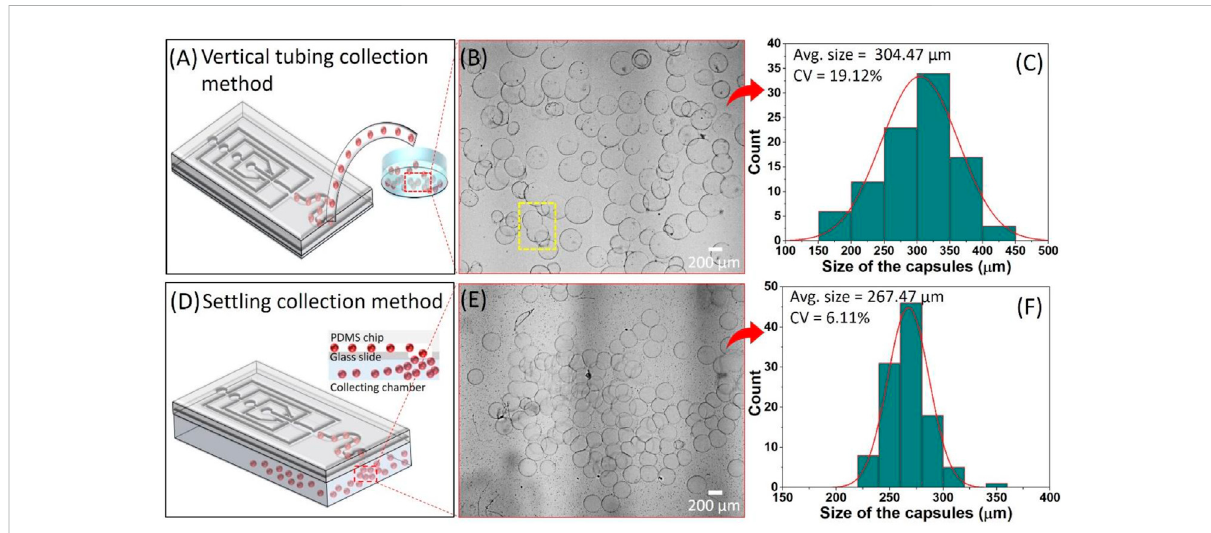
The collection of the hydrogel capsules by; (A – C) vertical tubing collection method, and (D – F) settling collection methods. (A,D) Schematic representation of the collection methods, (B,E) corresponding optical microscope image of the hydrogel capsules collected in PBS solution, and